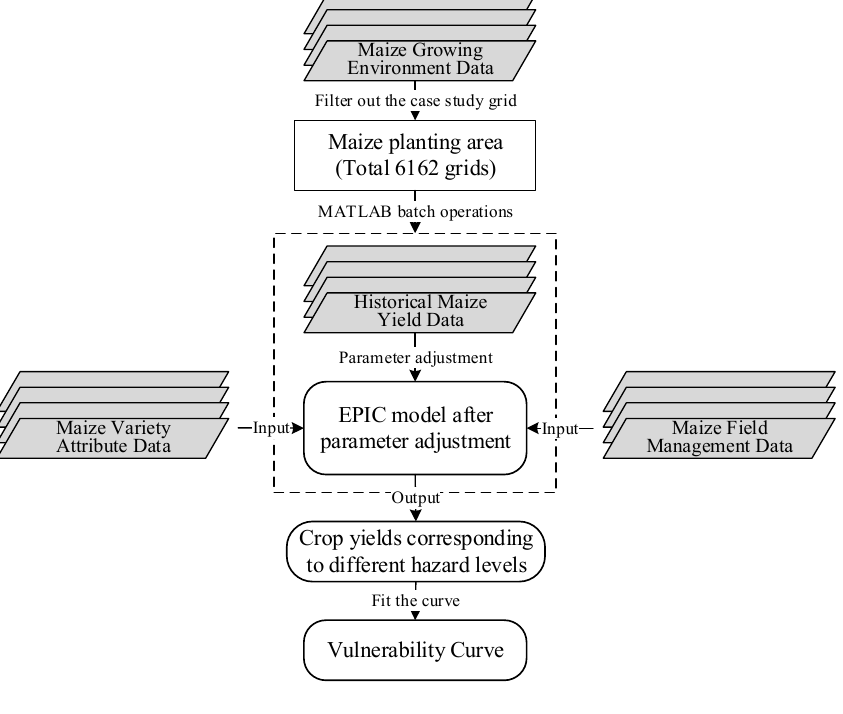
Figure 3. Process of EPIC model.